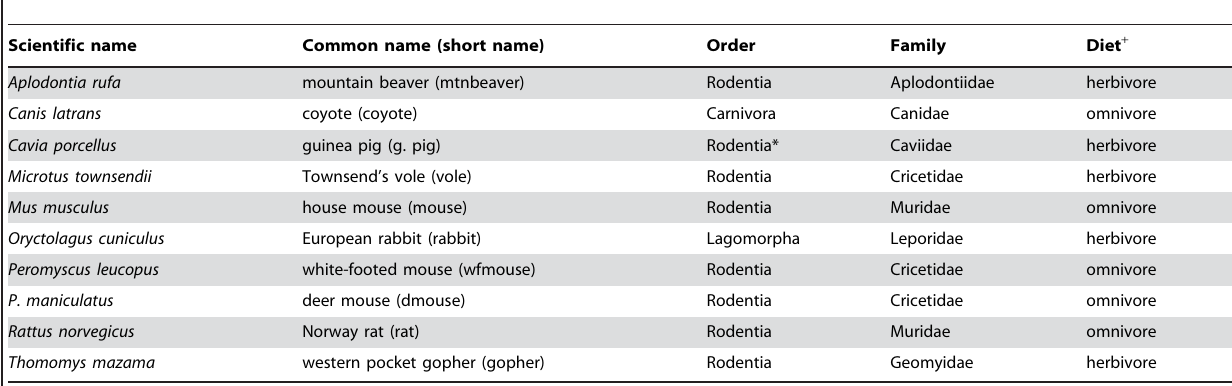
Table 1. Species tested in two-choice hydrolysate preference tests, including the short names used for figures and remaining